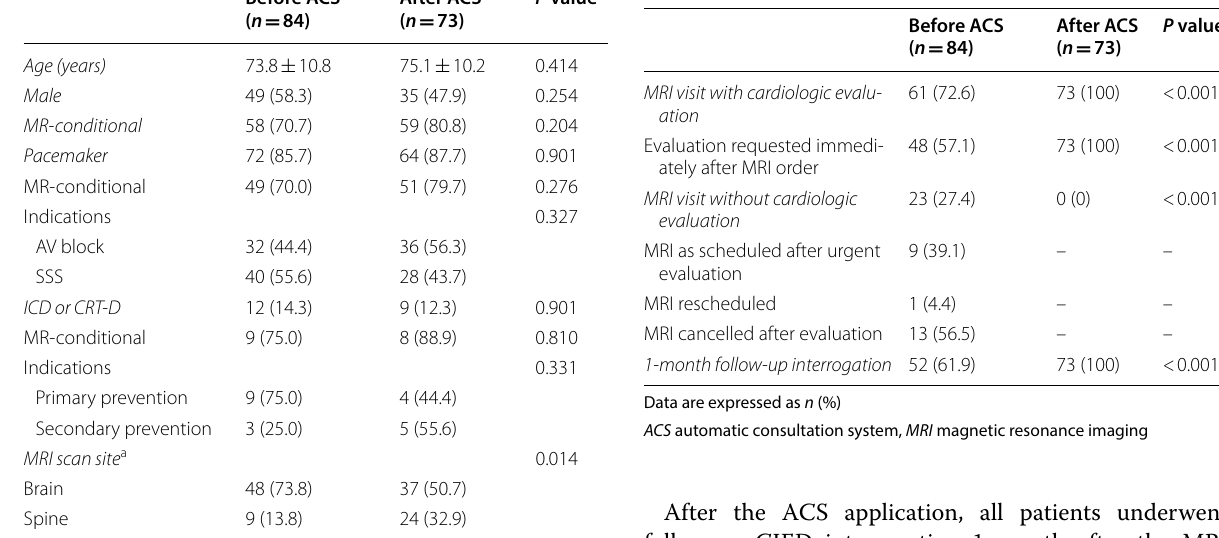
Table 1 Characteristics of the study population Table 2 Changes in the proportion of patients with pre- MRI cardiologic evaluation after the application of